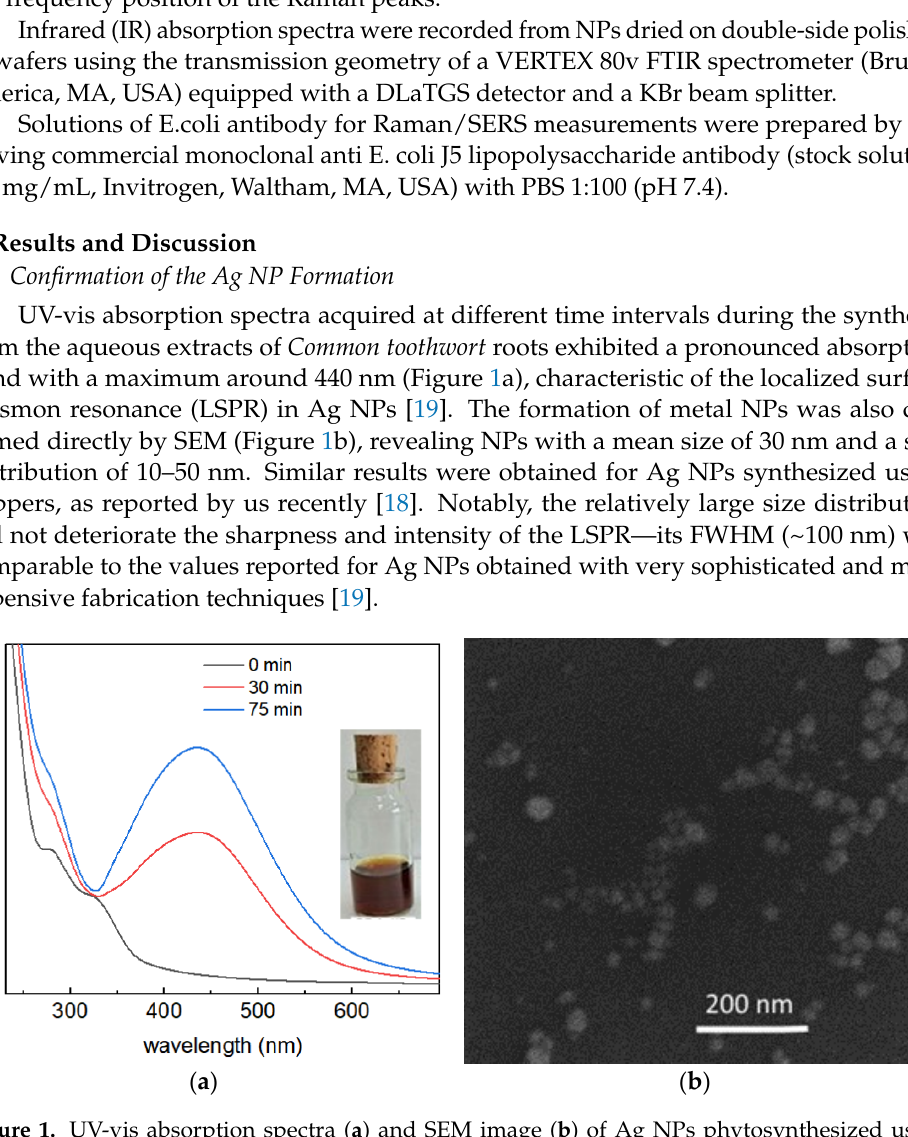
Figure 1. UV-vis absorption spectra ( a ) and SEM image ( b ) of Ag NPs phytosynthesized using aqueous extracts of common toothwort roots. The three curves in ( a ) correspond to different times after initiating the synthesis. The inset in ( a ) is a photograph of the final NP solution.